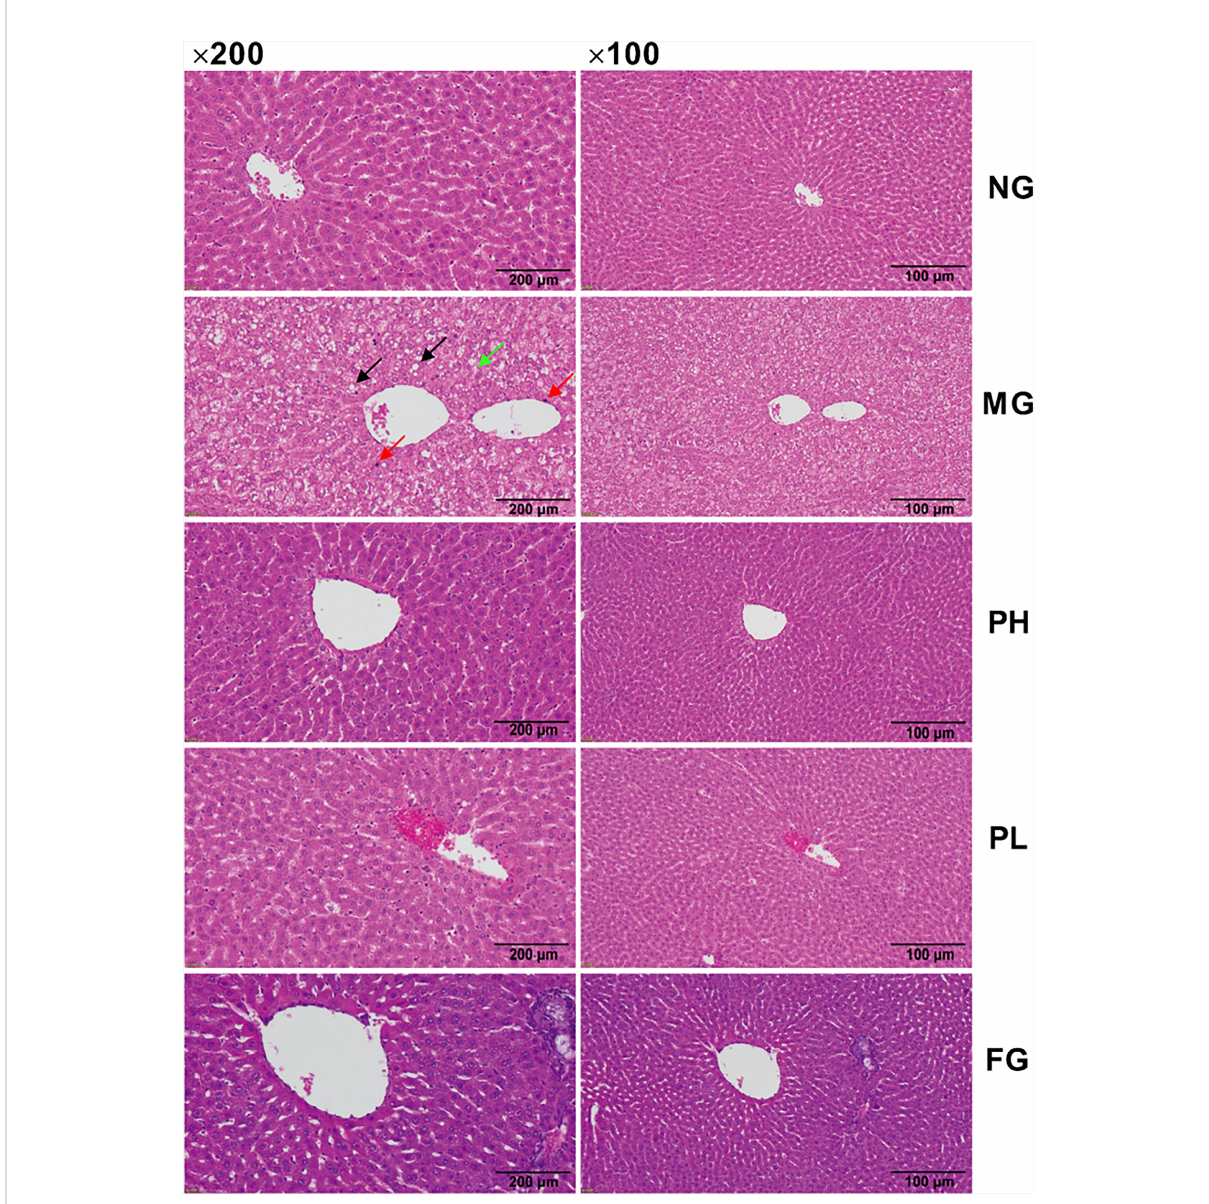
FIGURE 6 Hematoxylin and eosin (H&E) staining of liver (100× and 200× magni fi cation). The black, red, and green arrows represent fat vacuoles, in fl ammatory cells, and